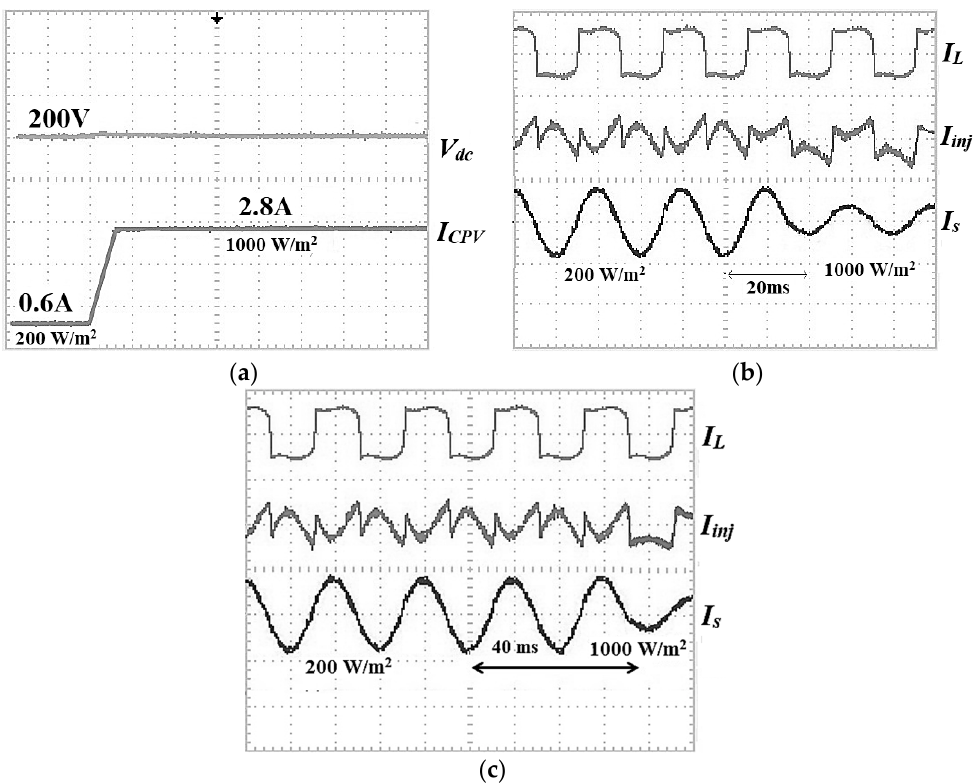
Figure 19. Experimental results of ( a ) self-charging with step size error cancellation DC link capacitor voltage control algorithm under change of irradiance of PV, with ( b ) Simpler ADALINE and ( c ) Modified Widrow–Hoff ADALINE current harmonics extraction algorithms covering load current I L (5 A/div), injection current I inj (5 A/div), and source current I s (5 A/div).